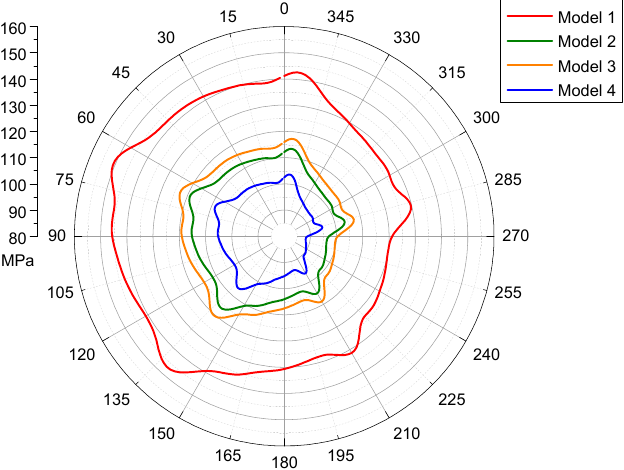
Figure 12. Maximum dynamic stress change rules of different root thickness blades.